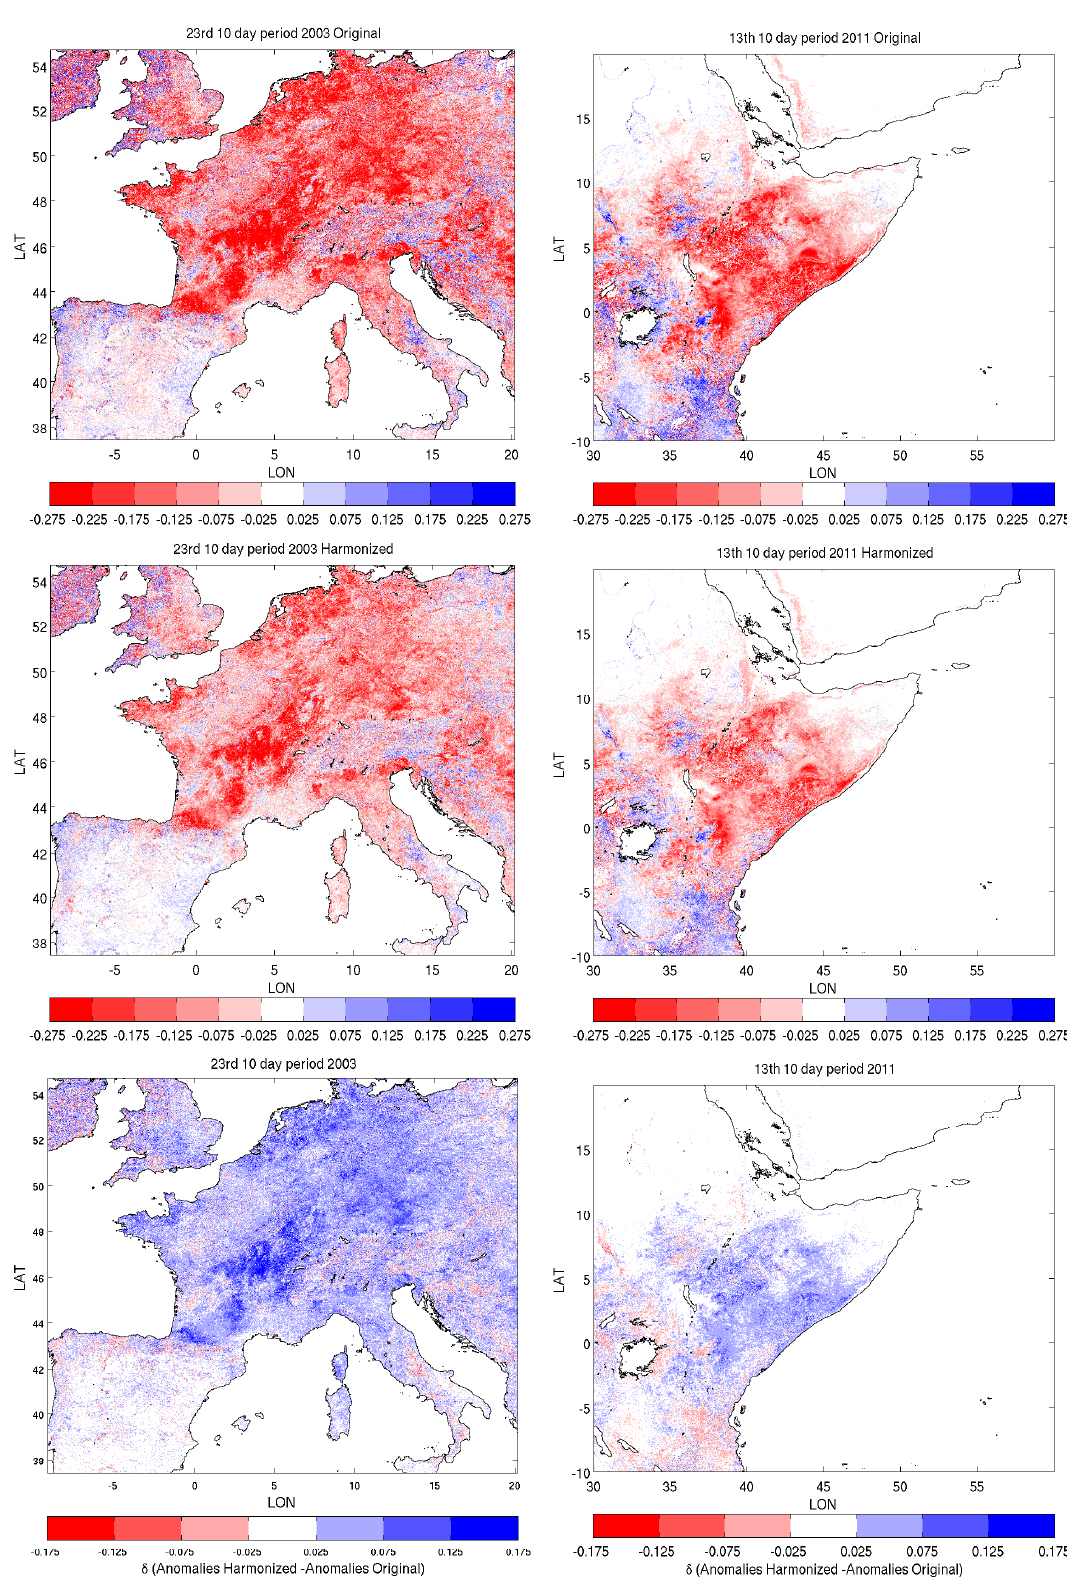
Figure 9. Anomalies of FAPAR calculated with the original ( top ) and harmonized ( middle ) products and differences (bottom) over the western part of Europe August 11–20, 2003 ( left ), and over the Horn of Africa June 1–10, 2011 ( right